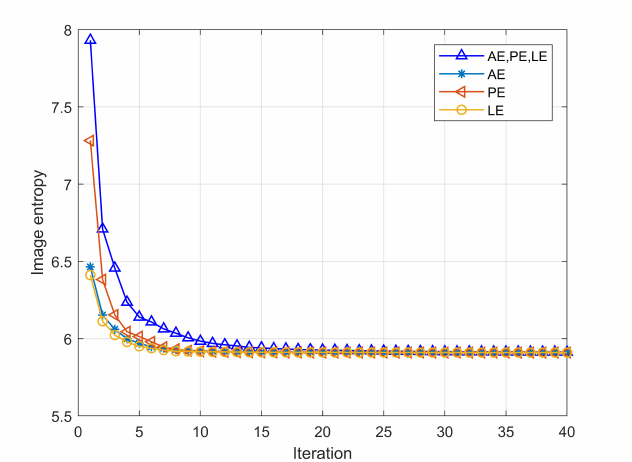
Figure 9. Image entropy after each iteration for the simulated multichannel SAR